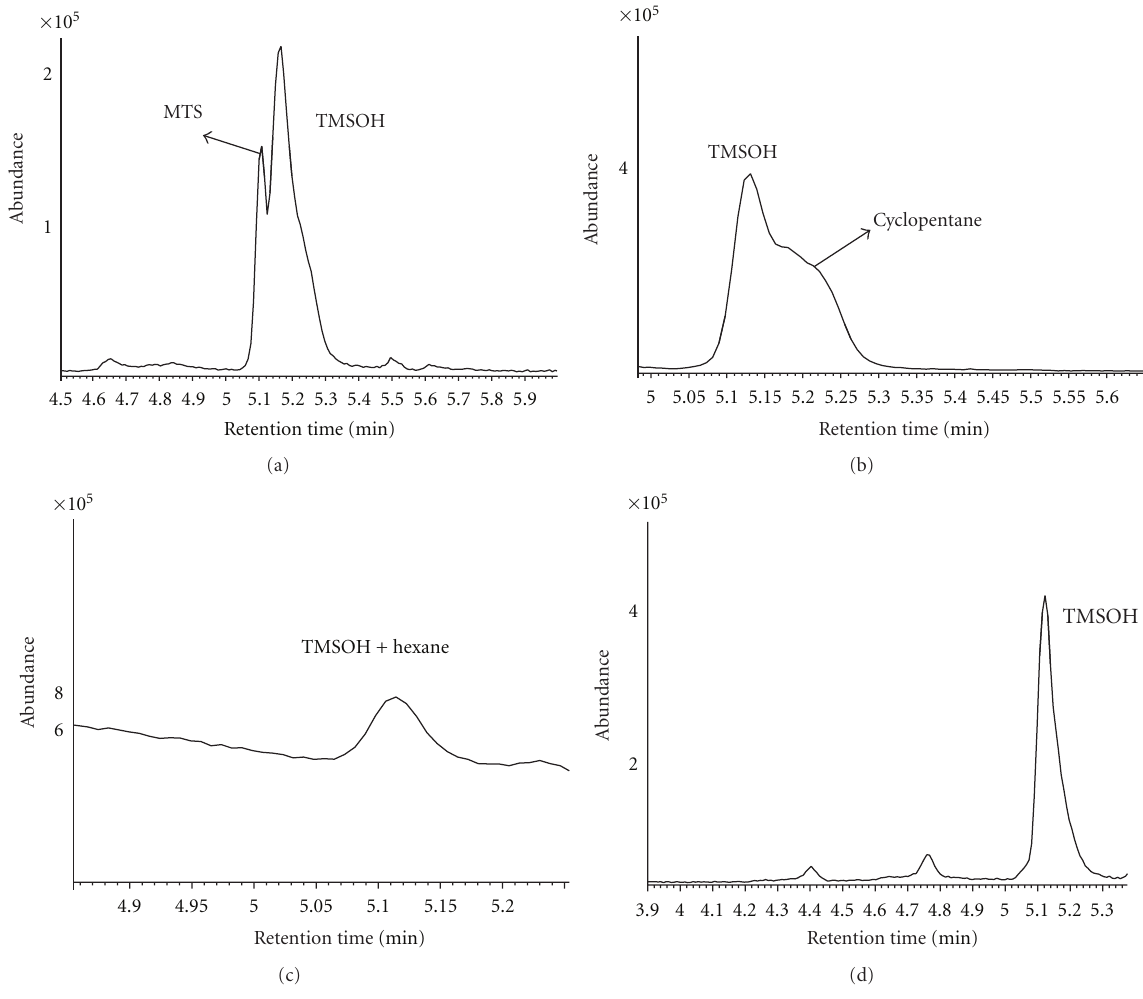
Figure 1: Solvent e ff ects on TMSOH separation. (a) methanol, (b) n-pentane, (c) n-hexane, and (d) n-decane. MTS: methoxytrimethylsi- lane. Samples were analyzed in scan